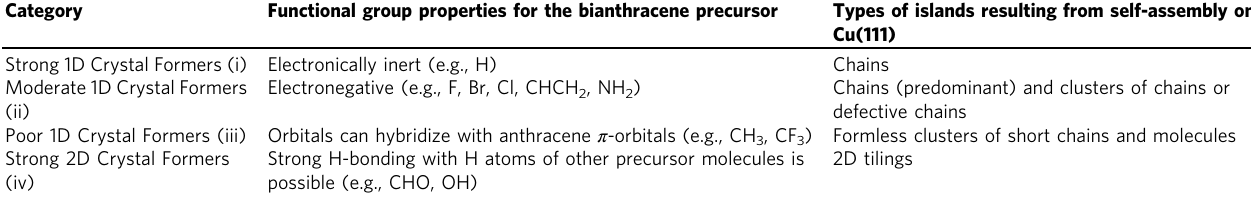
Table 1 Functional group properties associated with each category, and the types of islands formed upon self-assembly of bianthracene precursor molecules with functional groups with these properties (self-assembly on Cu(111) at low temperatures) Category Functional group properties for the bianthracene precursor Types of islands resulting from self-assembly on Cu(111) Strong 1D Crystal Formers (i) Electronically inert (e.g., H) Chains Moderate 1D Crystal Formers Chains (predominant) and clusters of chains or defective